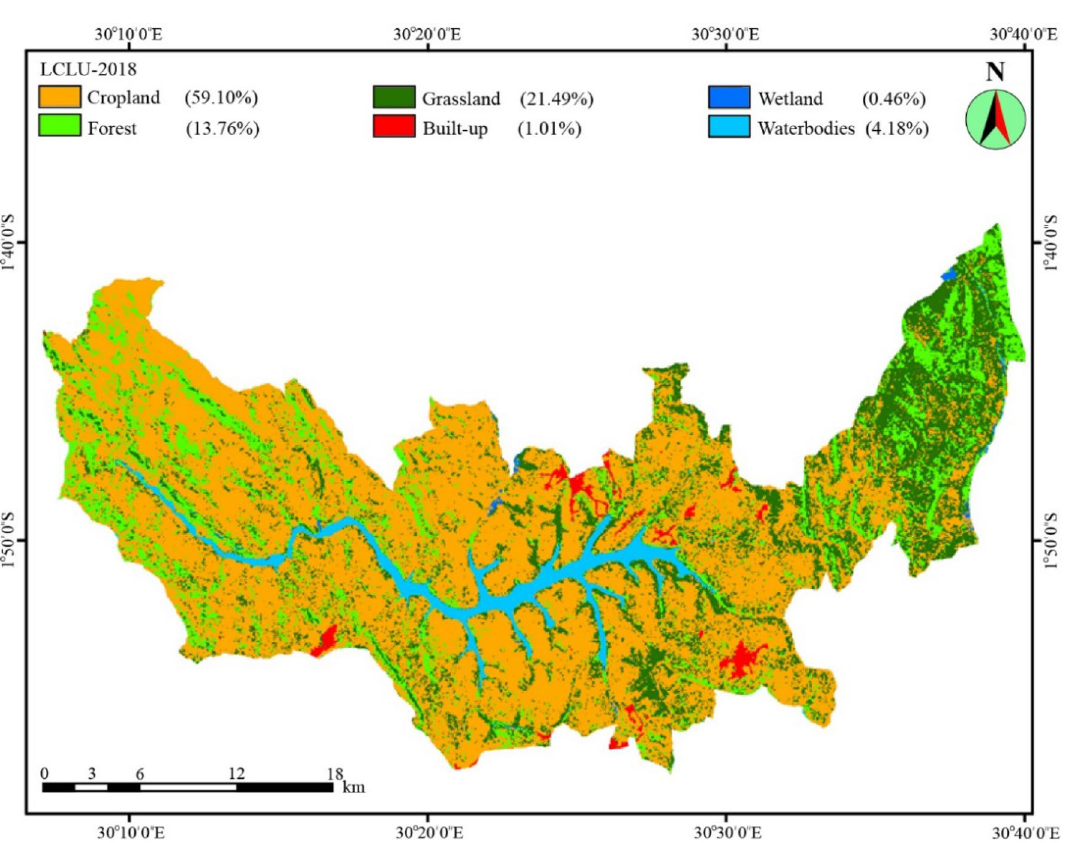
Figure 3. LULC classification map of the Lake Muhazi watershed (2018). Source: authors’ self-implementation with the ArcGIS software version 10.8 (http:// www. esri. com).